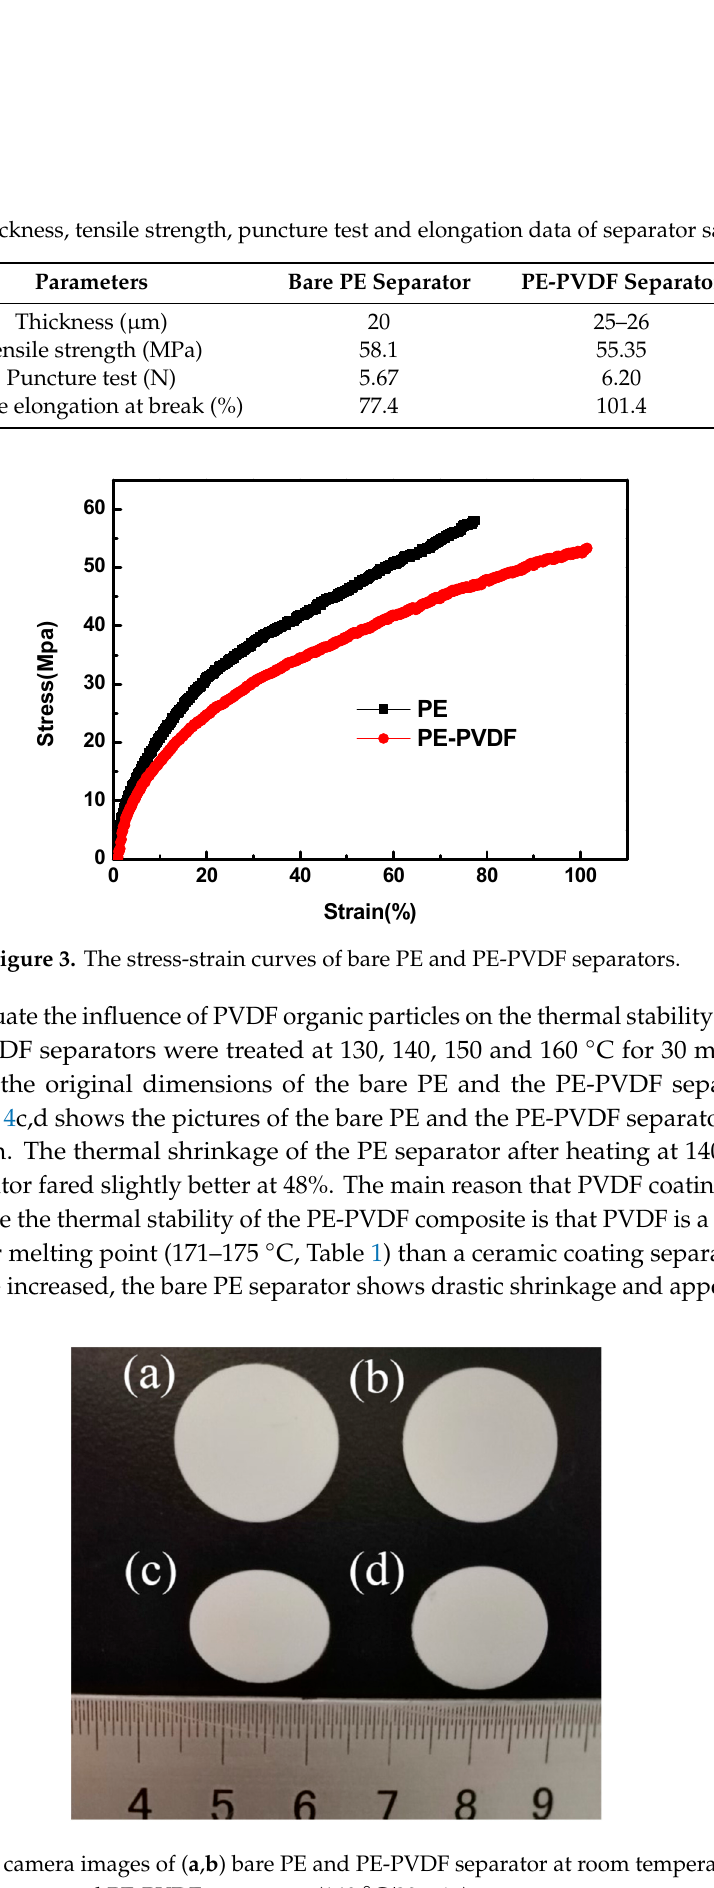
Figure 4. Digital camera images of ( a , b ) bare PE and PE-PVDF separator at room temperature (25 °C); ( c , d ) bare PE separator and PE-PVDF separators (140 °C/30 min).